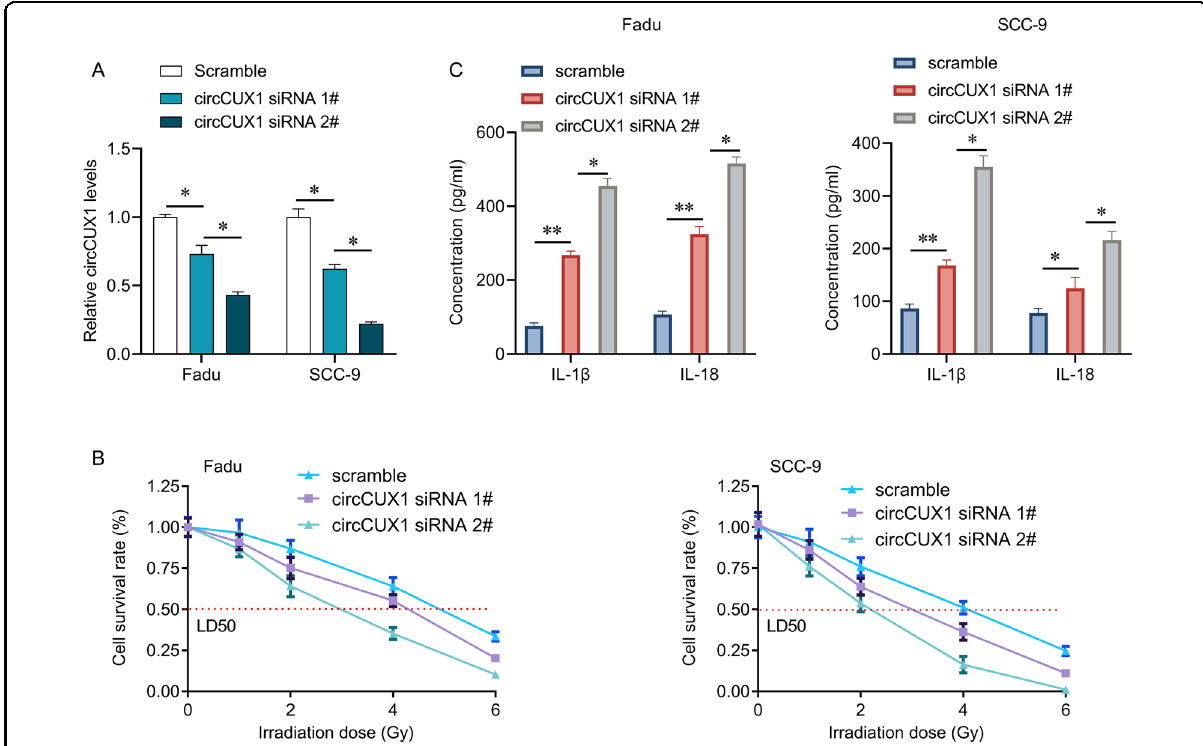
Fig. 5 CircCUX1 knockdown promotes radiosensitive of HPSCC. A qRT-PCR analysis for the expression of circCUX1 after siRNA transfection in Fadu and SCC-9 cells. B CCK-8 assay for the cell survival rate after siRNA transfection and irradiation in Fadu and SCC-9 cells. C The concentration of